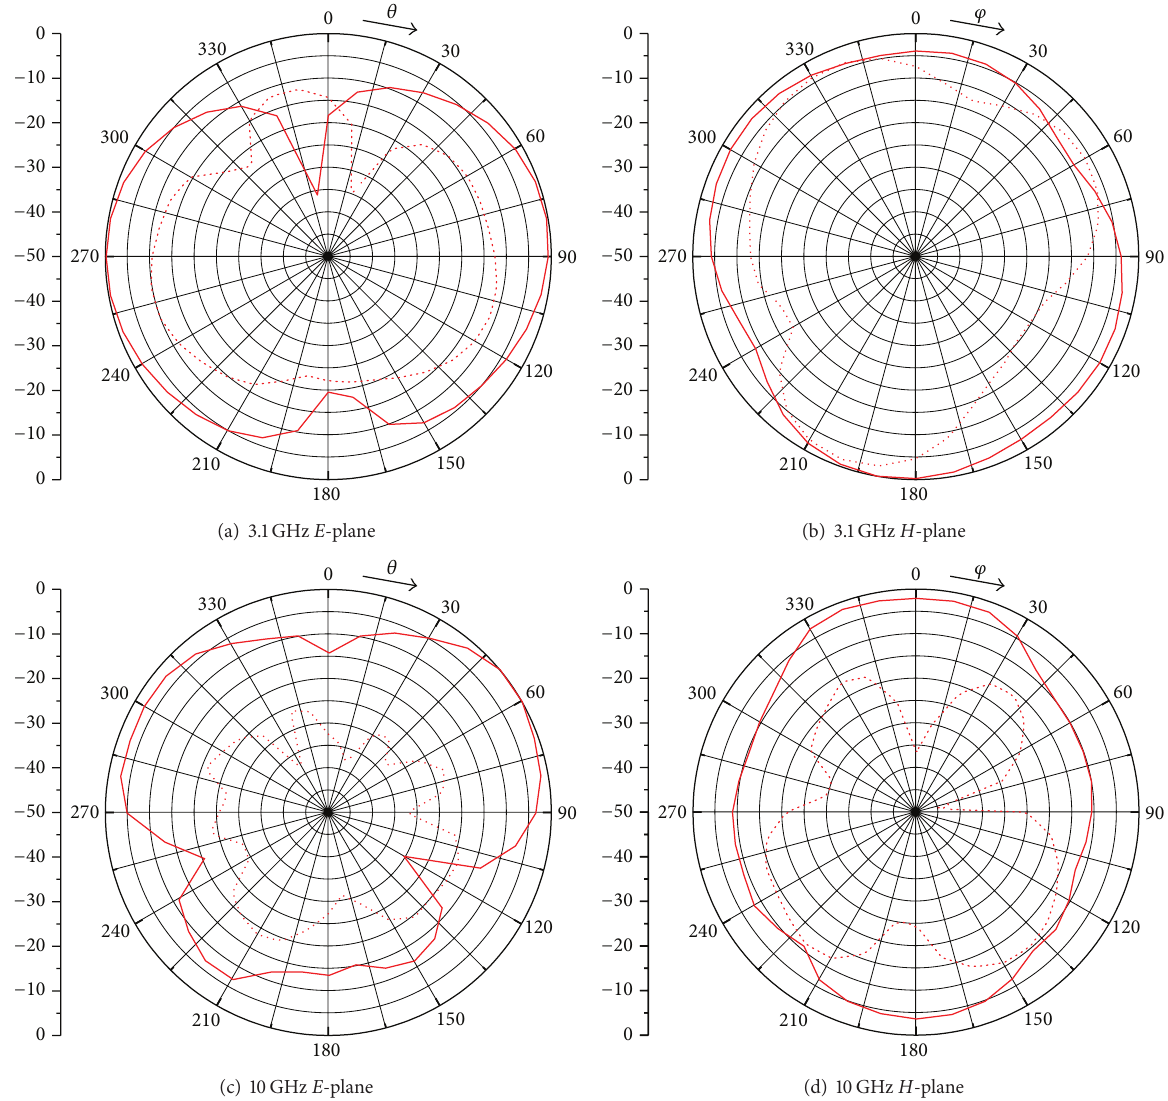
Figure 9: Normalized radiation patterns for the antenna without L-shaped slots loaded (solid line: copolar polarization and dash line: cross- polarization).